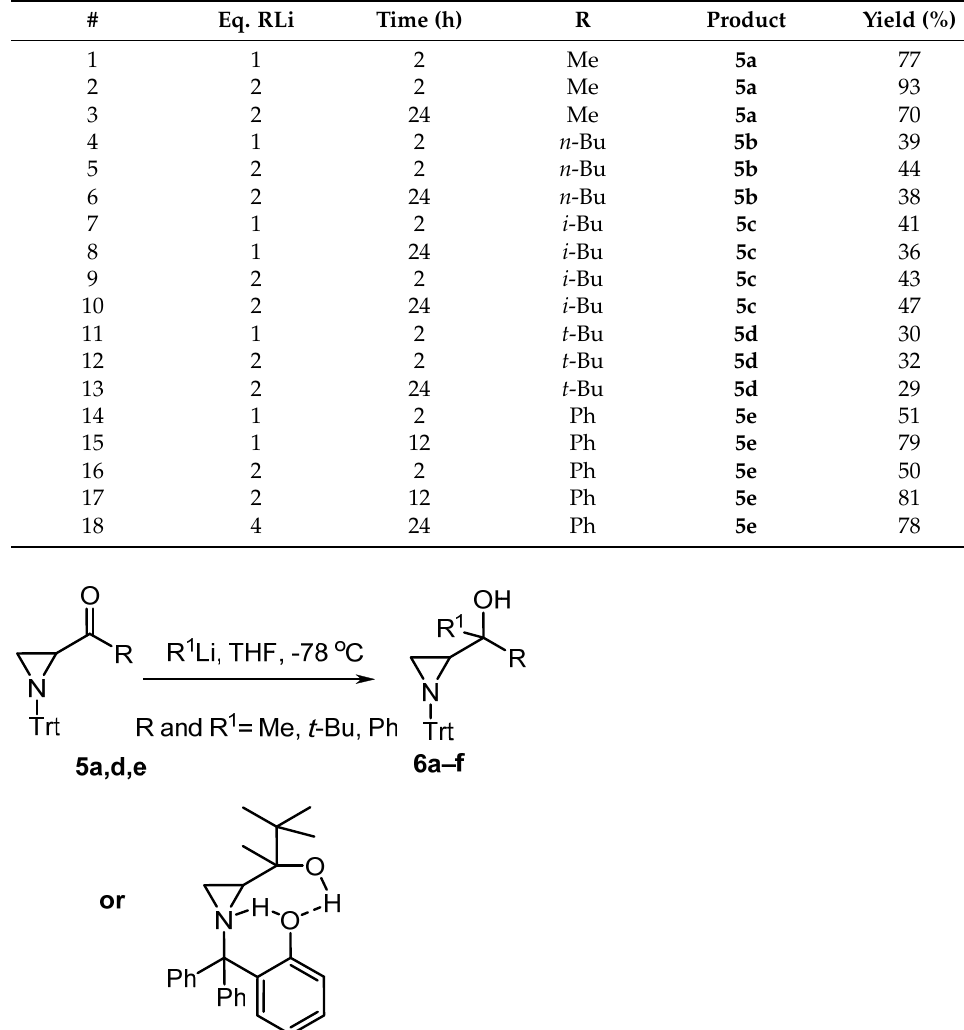
Table 2. Reaction conditions and yields of ketones 5a – e . When isolated ketones 5 interacted with the organolithium reagent (R 1 Li) once more, an addition to the substrate carbonyl group was observed. The corresponding symmet- rical or unsymmetrical carbinols 6a–f were isolated after the quenching of reaction mix- tures (Scheme 3, Table 3). The reaction of substrate 5a with methyllithium showed mod- erate yields of carbinol 6a (Table 3, entries 1–4). The aromatic group (PhLi as a reagent, product 6b ) and sterically hindered tert-butyl group ( tert -BuLi as a reagent, product 6c ) stimulated the formation of carbinols (Table 3, entries 5–12). Moreover, in reactions of ketones 5d, e with PhLi and tert-BuLi, longer reaction times increased yields of products 6b, c (Table 3, entries 6, 8, 11). The structure of carbinol 6c was confirmed by X-ray analysis (Figure 1). Ketone 5d reacted with MeLi unexpectedly in the N-trityl group, and instead of car- binol 6d, the hydroxylation product phenol 6d1 was isolated in a 52% yield (Table 3, entry 14). On the other hand, from ketone 5a in reaction with tert-BuLi (Table 3, entry 13), a carbinol 6d and a phenol 6d1 as a ~1:1 mixture were obtained. Formation of the phenol Table 3. Reaction conditions and yields of carbinols 6a–f and phenol 6d1. 6d1 may be a result of ortho-lithiation of the phenyl group in the substrate trityl moiety and will be a matter for further investigations. The structure of phenol 6d1 was confirmed by X-ray analysis (Figure 2).